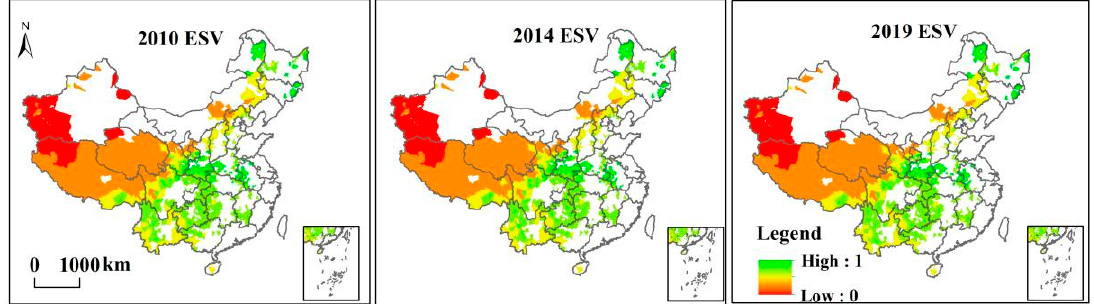
Figure 5. Spatial distribution of ES in national poverty counties.